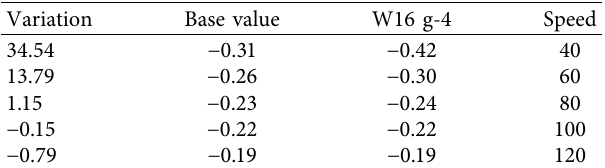
Figure 14: Comparison of lateral acceleration along the route at different vehicle speeds. Table 4: Percentage of changes in lateral acceleration on slope state of − 4% and wind speed of 16